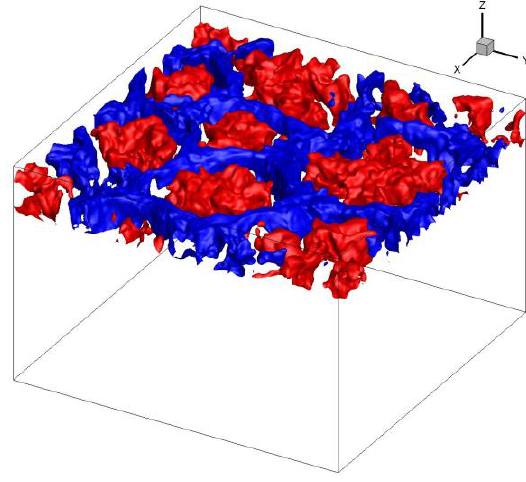
Figure 3. Time evolution of the water temperature ( a ) and vertical velocity component ( b ) at differ- ent depths (Variant 1).